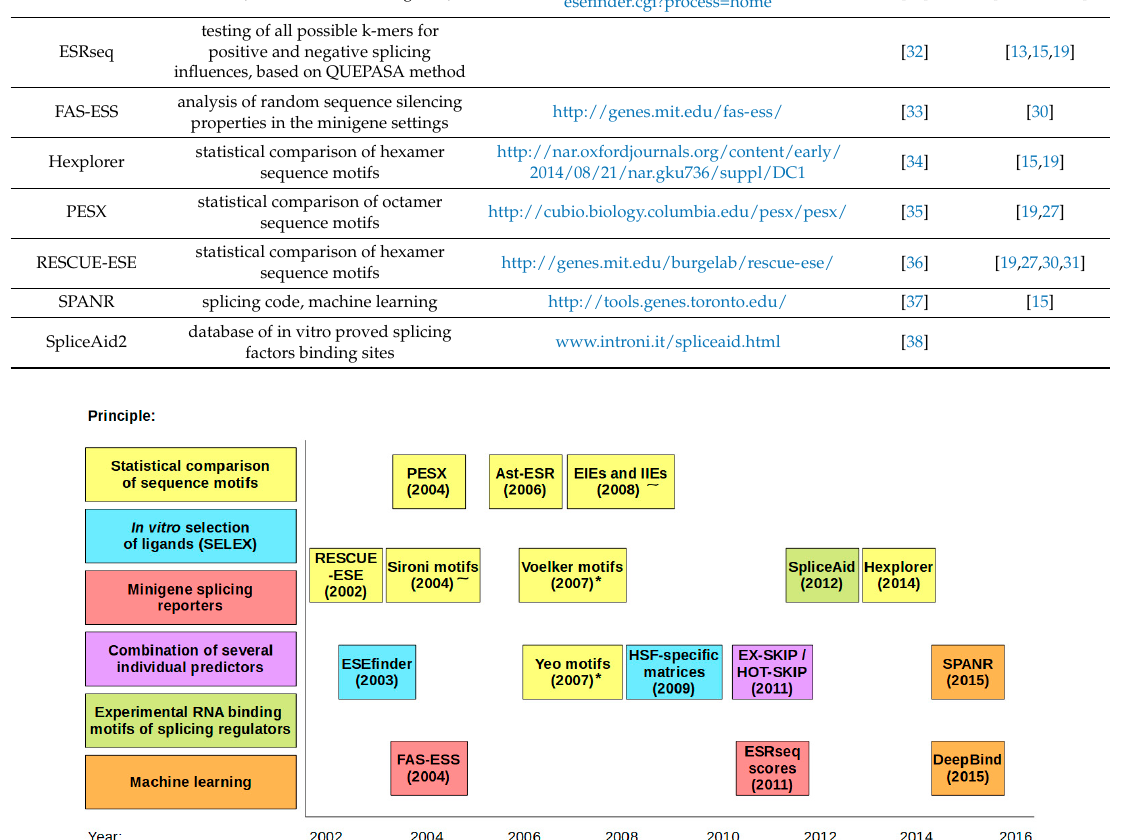
Figure 1. Individual approaches to SRE predictions showing the first release of the online tools (* denotes the tools that are accessible via Sroogle engine; ˜ denotes the tools that are accessible via Human Splicing Finder (HSF) engine).